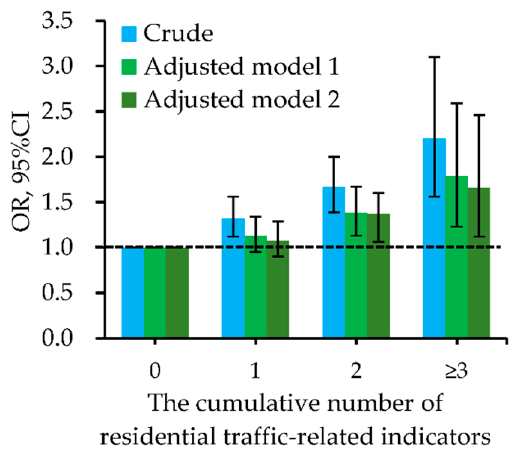
Figure 2. Dose-response relationships of the cumulative number of indictors for residential traffic within 200 m of the residence with odds of childhood pneumonia. Adjusted factors in model 1 (multivariate logistic regression analyses) included sex, age, residence-located area, family history of atopy, residence ownership, breastfeeding duration, household dampness-related exposures, household ETS, and household renovation during early lifetime. Adjusted factors in model 2 (two-level logistic regression analyses) included sex, age, family history of atopy, residence ownership, breastfeeding duration, household dampness-related exposures, household ETS, and household renovation during early lifetime. The supplemental Table S4 presented the detailed data for odds ratios (ORs) and their 95% confidence intervals (CIs).